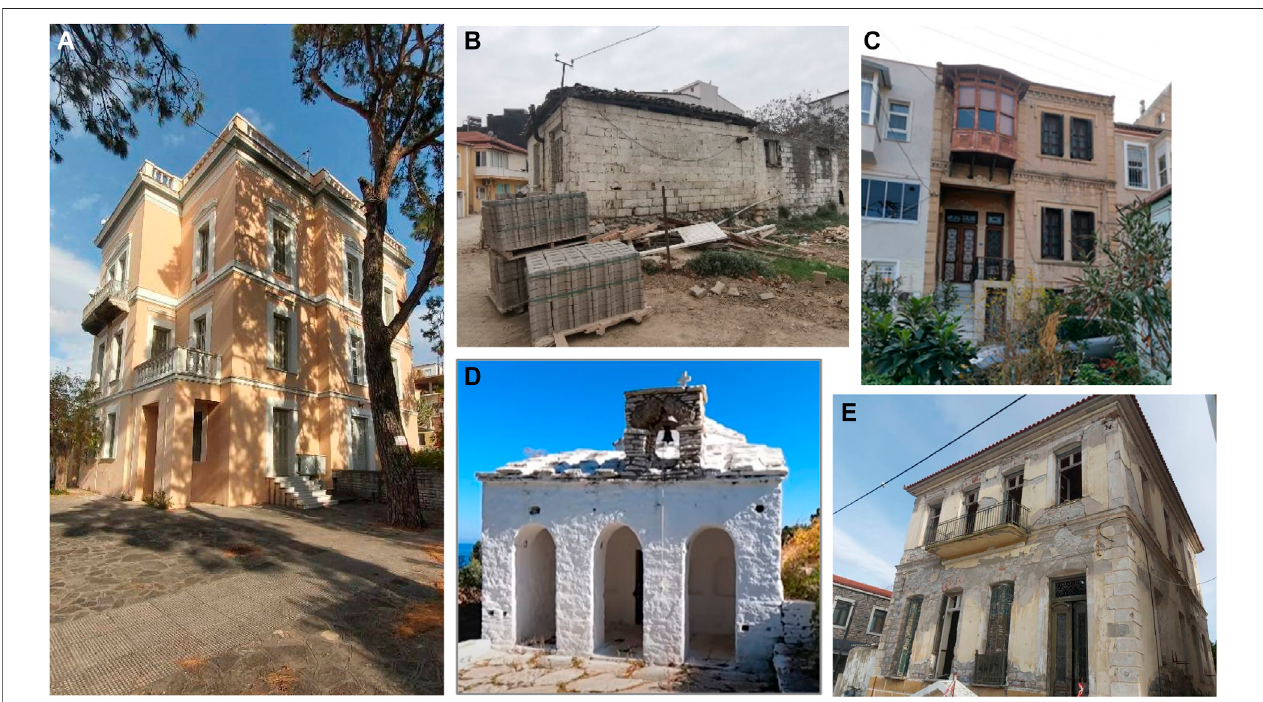
FIGURE 13 | Examples of masonry building stock in the affected areas [ (A,D,E) in Samos, (B,C) in Izmir].